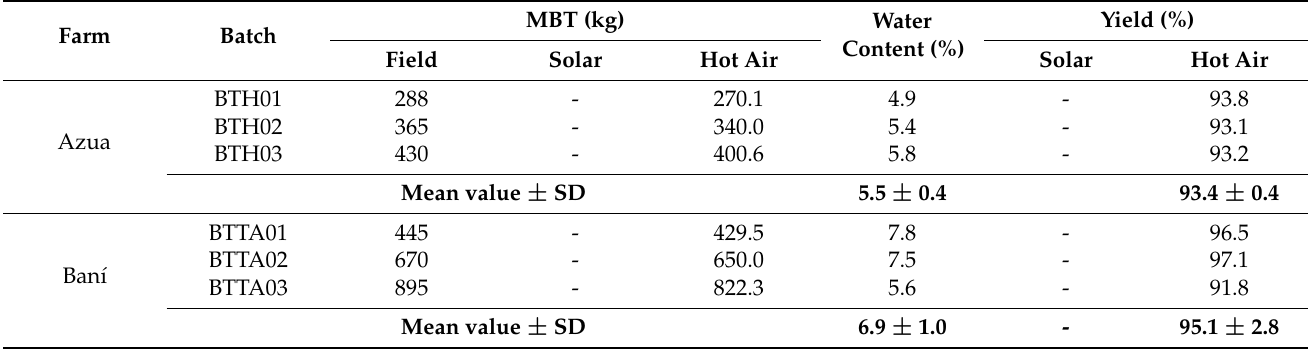
Table 4. Yield of mango branch tree and water content after drying.